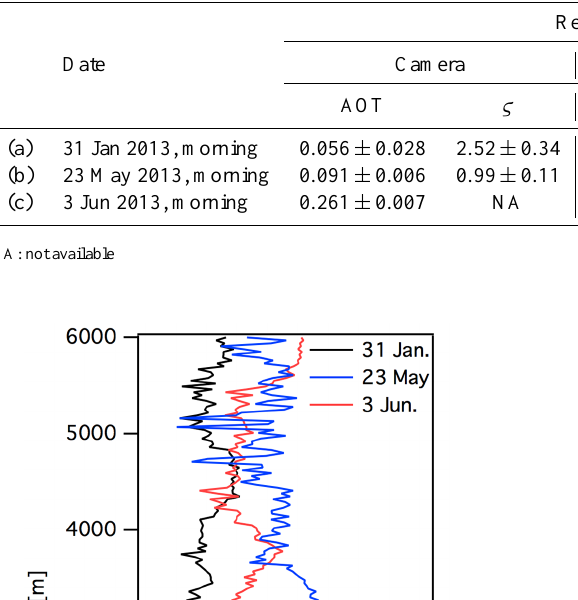
Table 6. Retrieval results and SPRINTARS model simulation results for case studies.